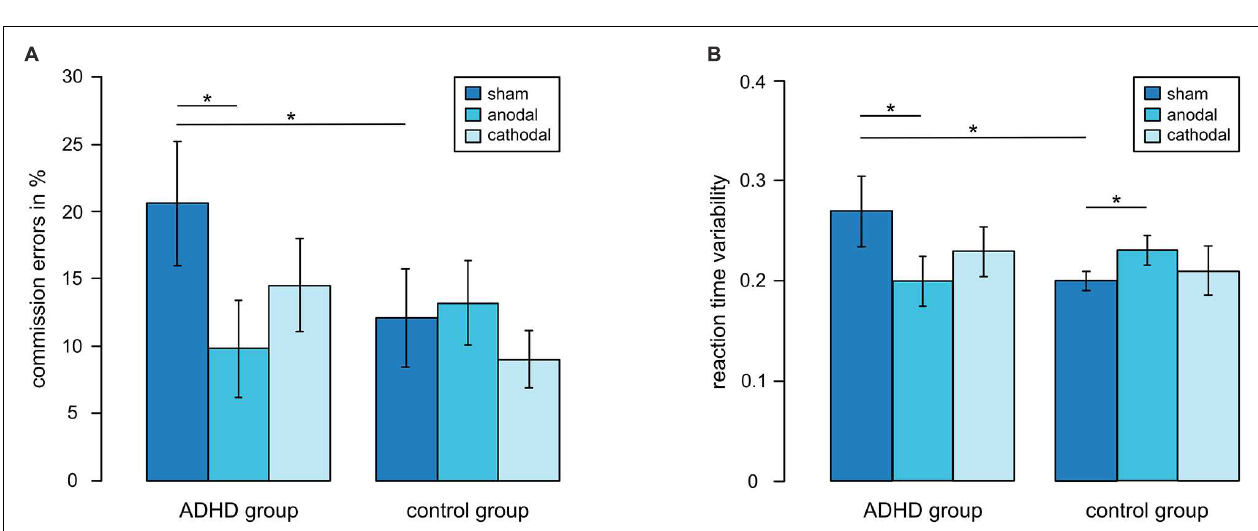
FIGURE 3 | Performance for first sessions in different tDCS conditions. (A) Commission errors, (B) reaction time variability, ∗ p < 0.05, error bars represent one standard deviation.